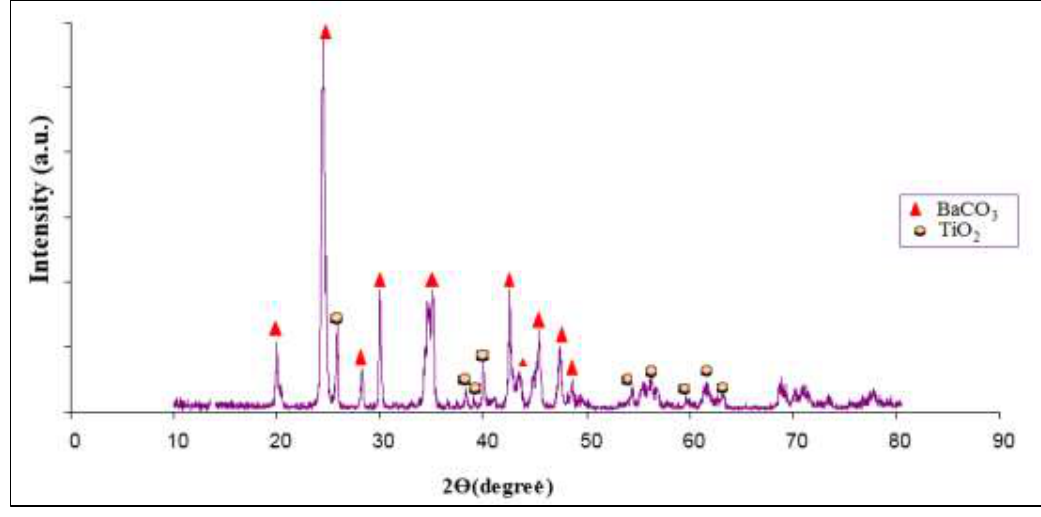
Figure 5: Barium Carbonate BaCO 3 & Titanium oxide TiO 2 XRD pattern before